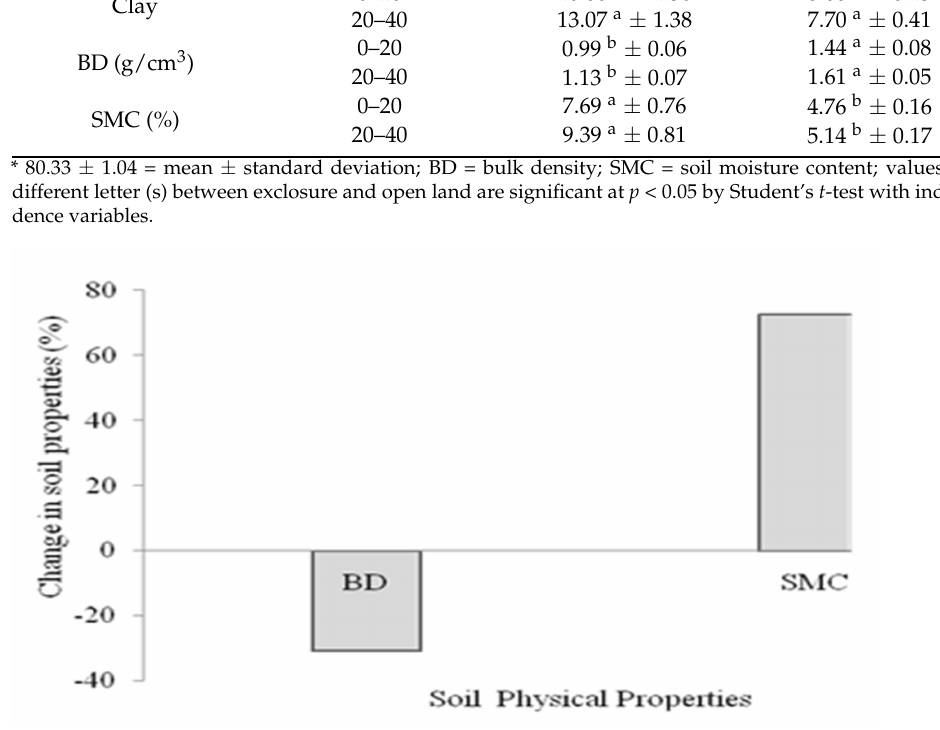
Figure 2. The increase and decrease in soil physical properties due to natural rehabilitation of degraded land by exclosure within overall (0–40 cm) depth. BD refers to bulk density and SMC refers to soil moisture